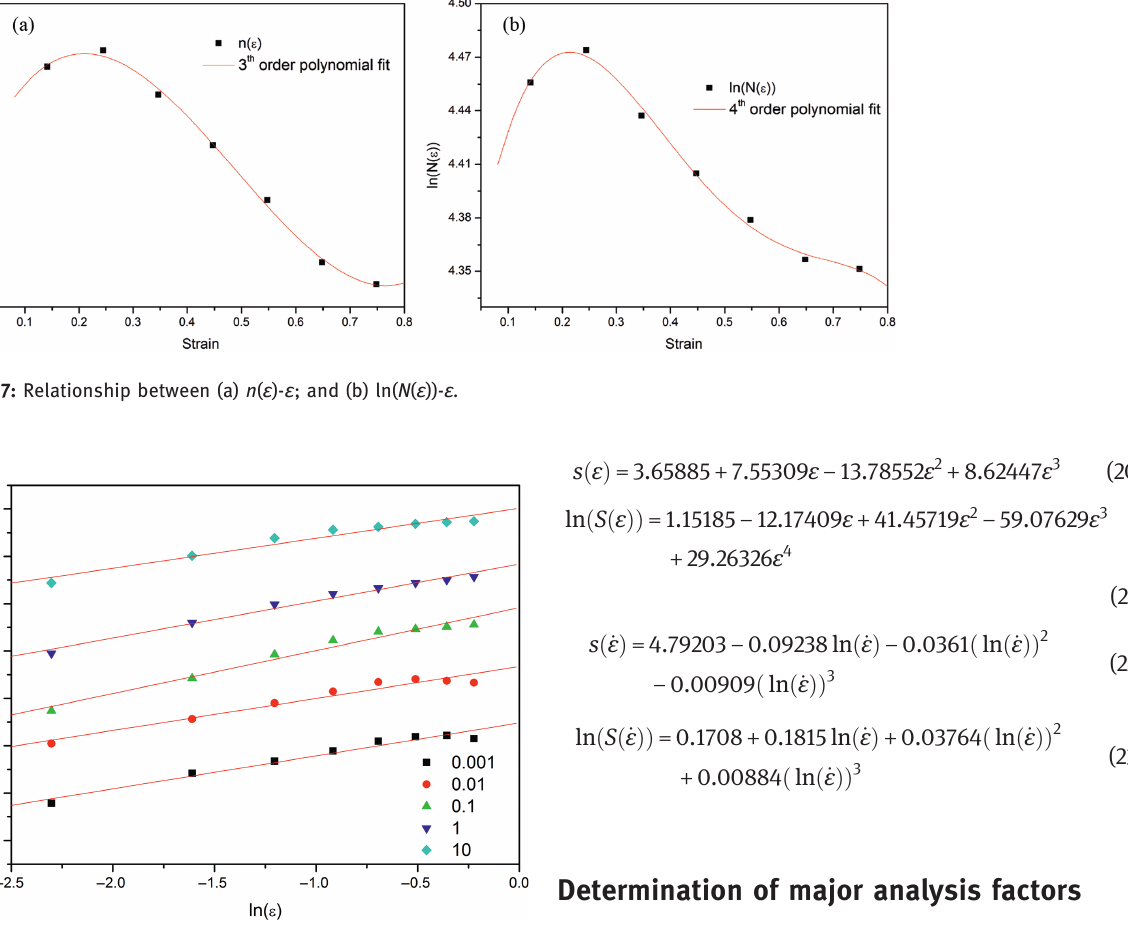
Figure 8: Relationship between ln ð (cid:2) σ ð ε − _ ε ÞÞ and ln ð ε Þ .